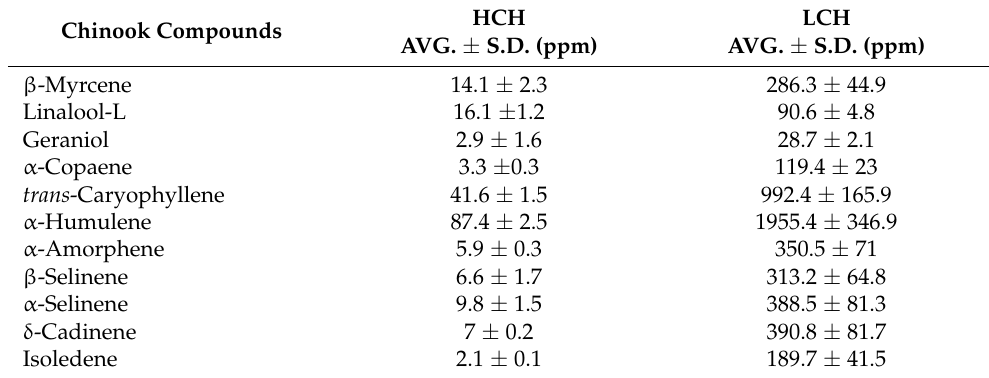
Table 6. Chinook compound distribution in the HCH and LCH samples showing triplicate average (AVG.) and standard deviation